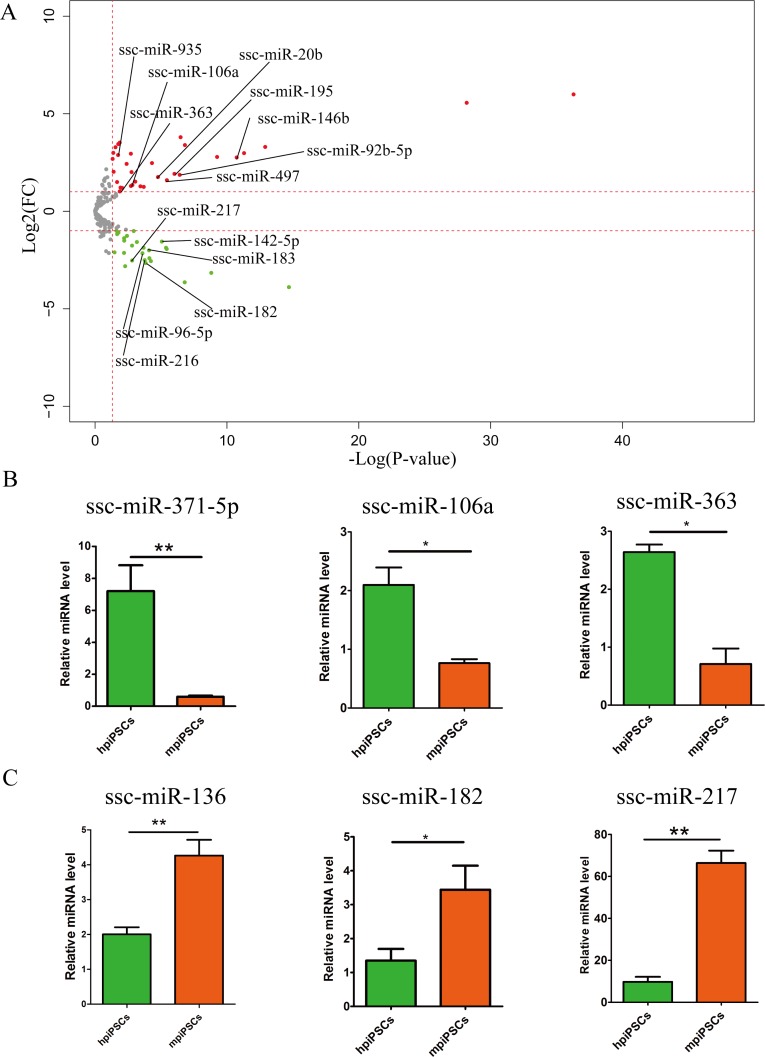
The specific DE miRNAs of hpiPSCs and mpiPSCs.(A) Volcano plot of hpiPSCs versus mpiPSCs. Red plots indicate DE miRNAs up-regulated in hpiPSCs. Green plots indicated DE miRNAs down-regulated in hpiPSCs. DE miRNAs were selected by |log2(FC)|≥1, P-value <0.05. (B) Relative expression of selected hpiPSCs-specific miRNAs. (C) Relative expression of selected mpiPSCs-specific miRNAs.